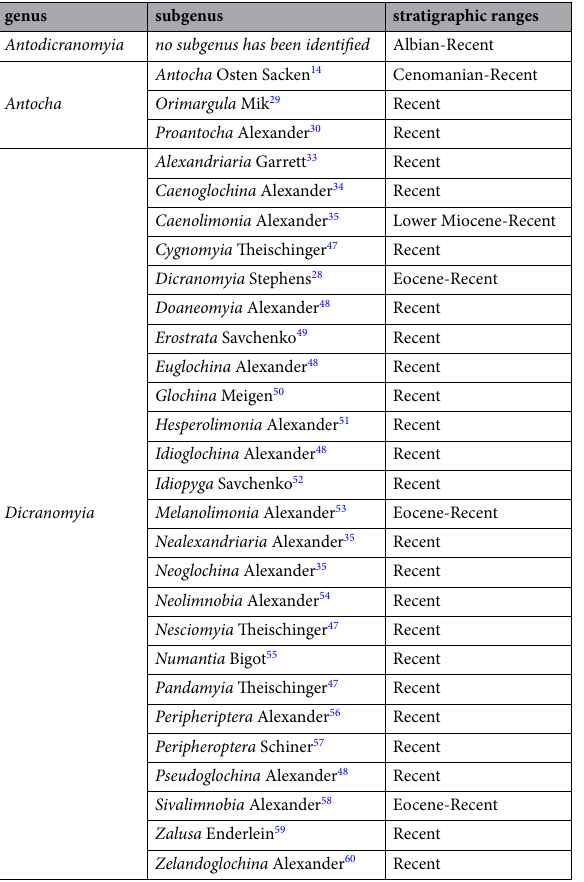
Table 1. List of subgenera of Antodicranomyia , Antocha and Dicranomyia with information about their